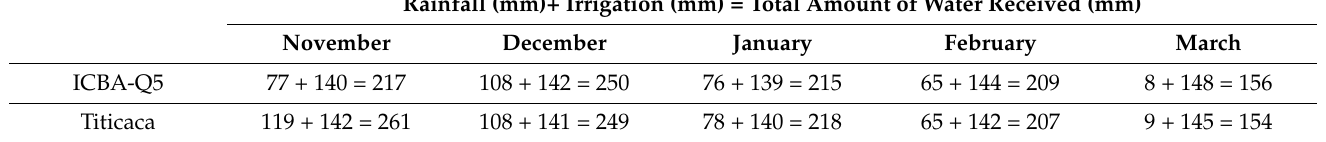
Table 1. Amount of water received by each sowing date and cultivar.